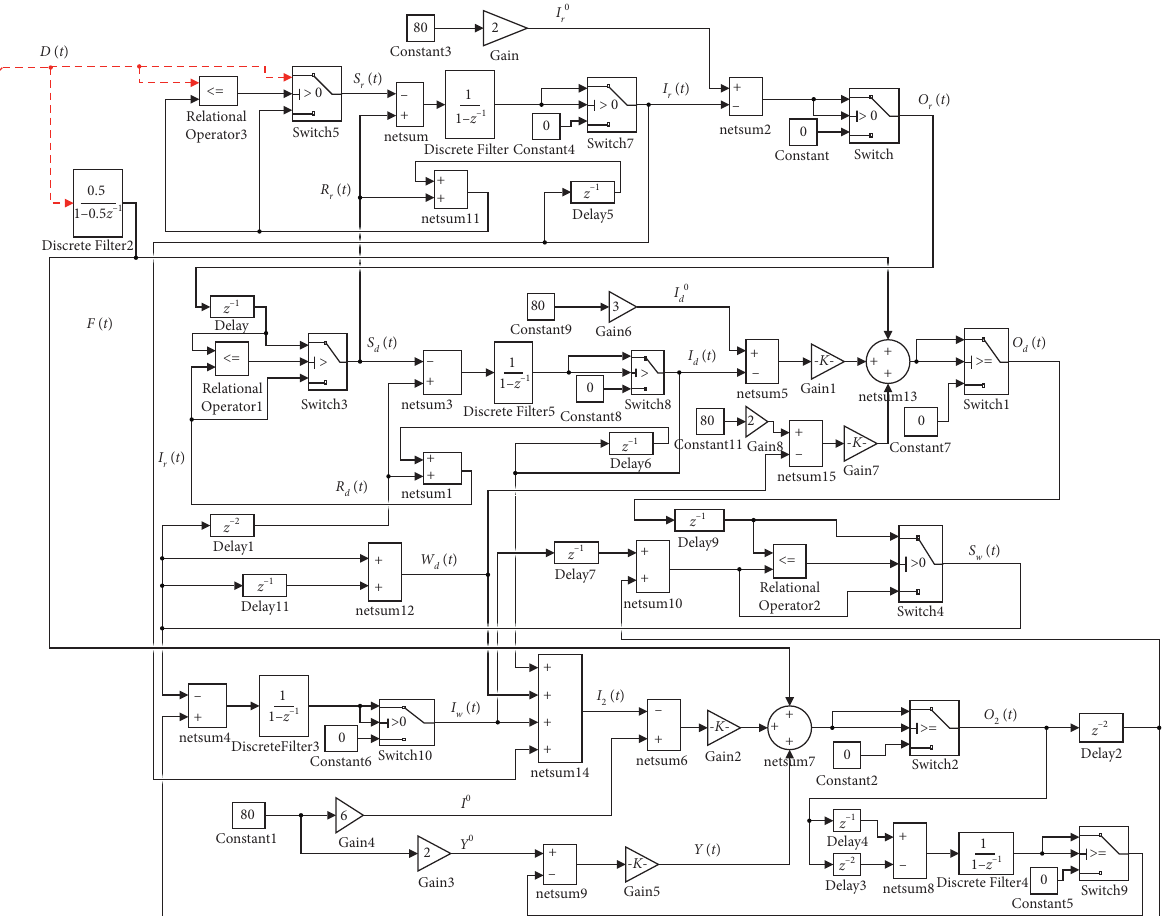
Figure 6: The block diagrams of the system under the global decision ) and Y ( t ) are distance L points is traced until t i , two points Y ( t between the two points should be less than ε , and 1 0 1 1 obtained, and the distance L 1 the angle formed should be as small as possible. The evolution between them exceeds a specified 0 ) and find a point Y ( t ) near it. The process is continued until Y ( t ) reaches the end N of the time value ε . Keep Y ( t 1 1 1